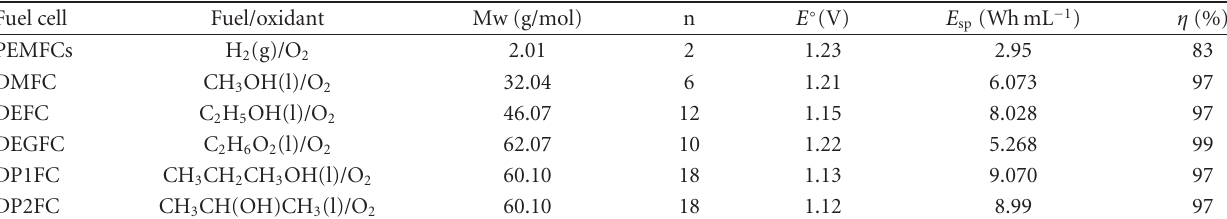
Table 1: The characteristics of di ff erent fuel